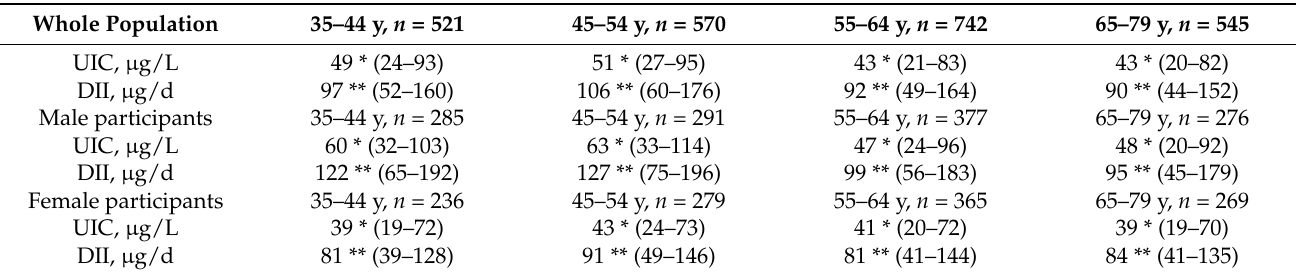
Table 2. Medians (IQR) of urinary iodine concentration (UIC) and daily iodine intake (DII) by age class in the whole study population and by gender.